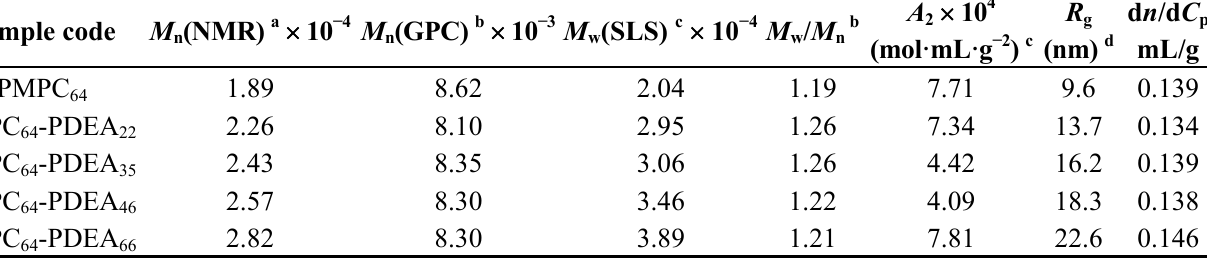
1. Characteristics of poly(2-(methacryloyloxy)ethyl phosphorylcholine)- b -poly( N , N -diethyl -PDEA acrylamide) (PMPC m n